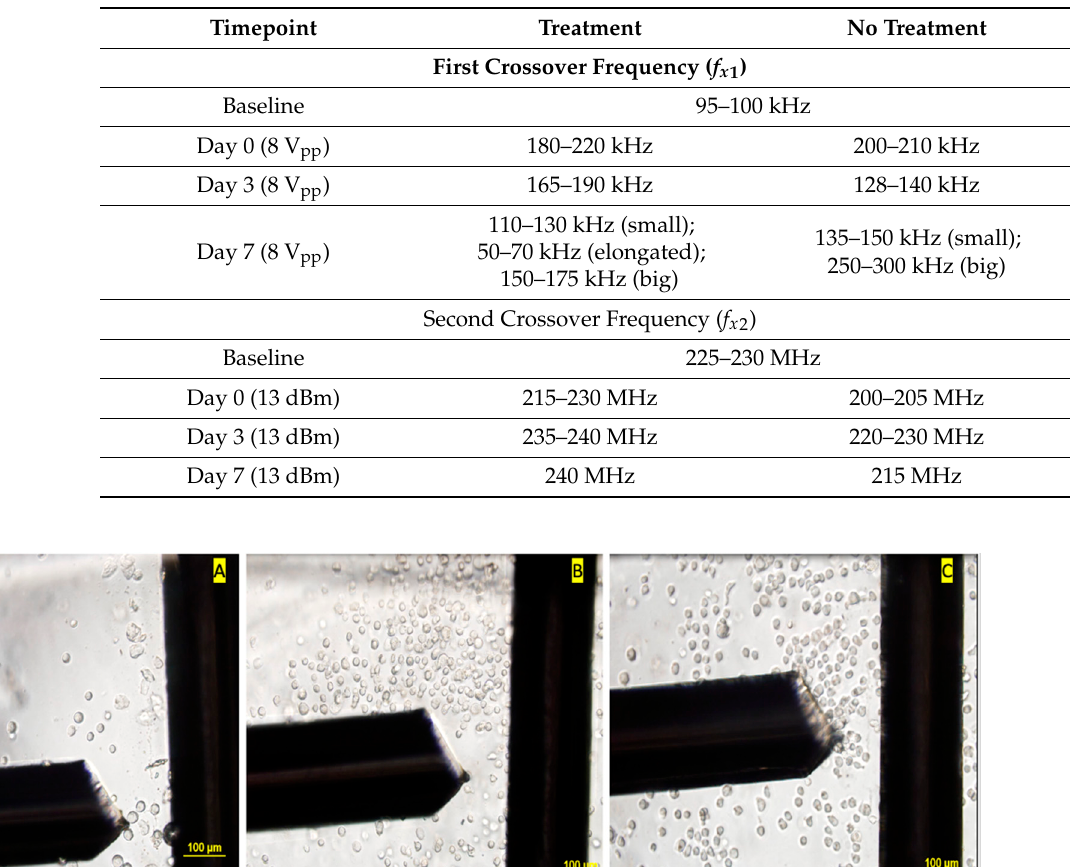
Table 1. Table reporting the stem cell first and second crossover experiment values for baseline and days 0, 3, and 7. Day 7 cells experienced extreme heterogeneity consisting of small, large, and elongated cell populations. The medium conductivity for all the experiments was maintained at 0.06 S/m.